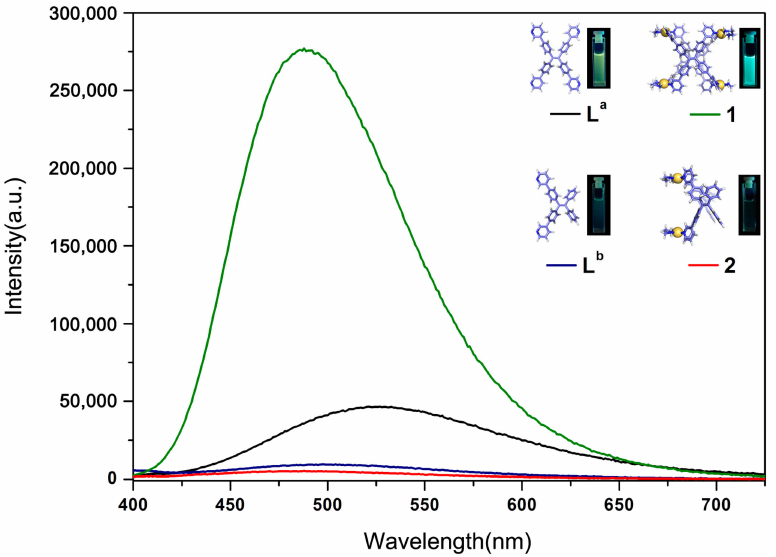
Figure 4. Fluorescence emission spectra of ligand L a ( λ ex = 365 nm), L b ( λ ex = 343 nm) and assemblies 1 ( λ ex = 372 nm) and 2 ( λ ex = 358 nm) in H 2 O/acetone ( v : v = 1:1) at the same ligand concentration of 50 µ